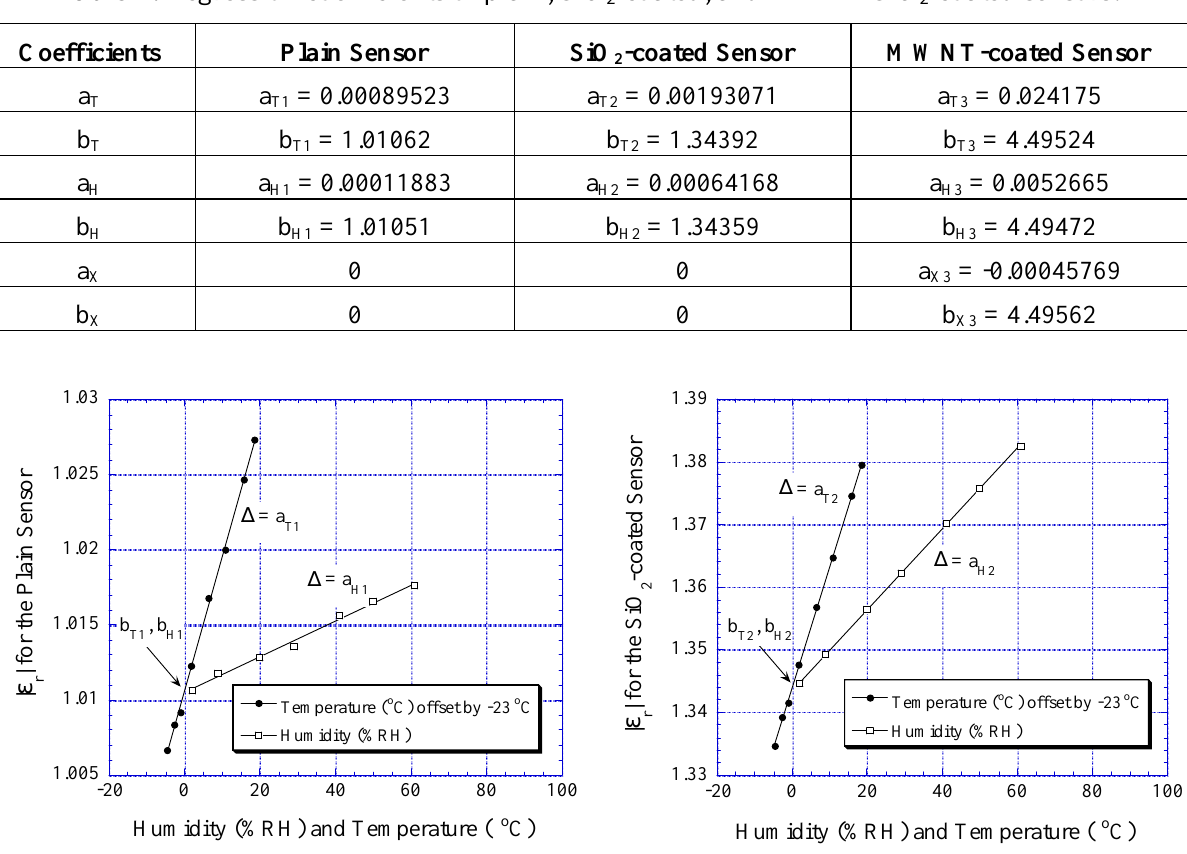
Table 1. Regression coefficients of plain, SiO Coefficients Plain Sensor SiO